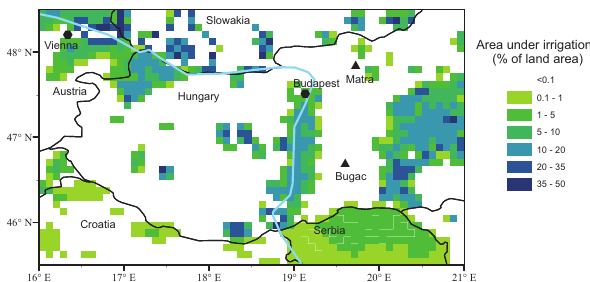
Fig. 2. Transdanubian test region and percentage of irrigated area obtained from the global map of irrigation areas provided by the FAO’s global information system on water and agriculture at a resolution of 5 0 (Siebert et al., 2007). The black lines represent country boundaries. The light blue line indicates the river Danube. The locations of the meteorological towers Matra and Bugac are indicated with black